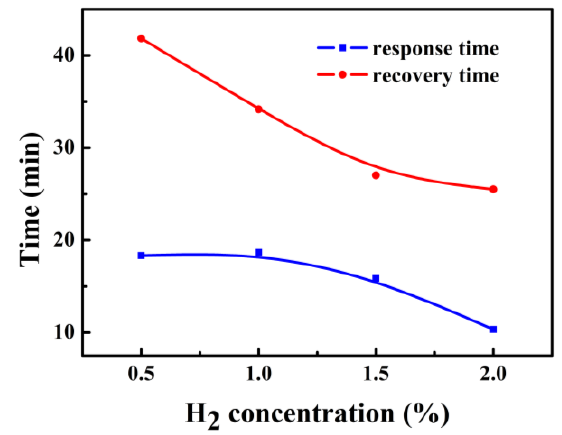
Figure 9. The response time and the recovery time of the PdNi film sensor.